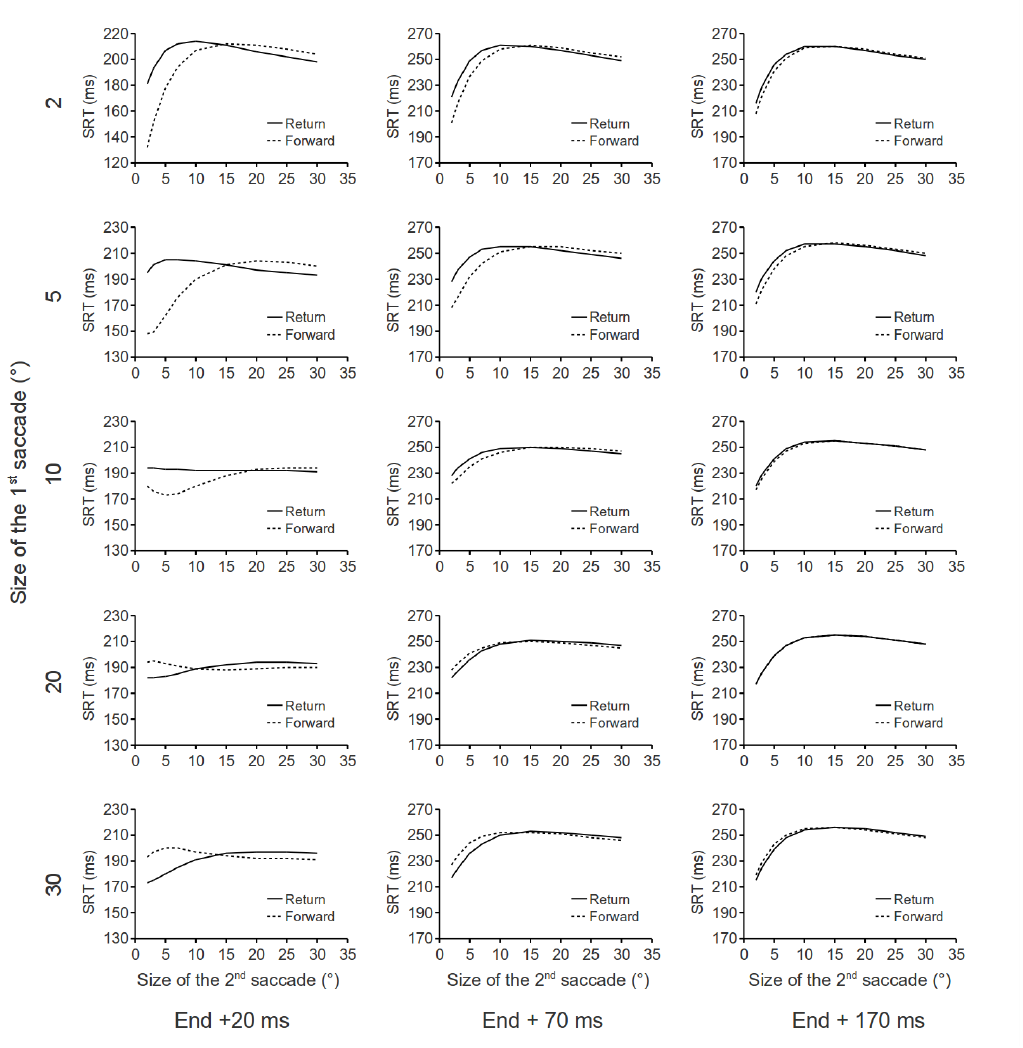
Figure 3 Parametric testing of the aftereffects of a saccade in our DNF model. In each panel saccadic RT is plotted as a function of the amplitude of the second saccade. Timing of the input to the network for the 2nd saccade is represented in the columns and amplitude of the preceding saccade is represented in the